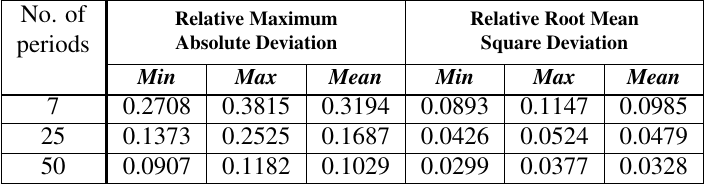
TABLE I. Extreme and Mean Values for the Relative Maximum Absolute Deviation